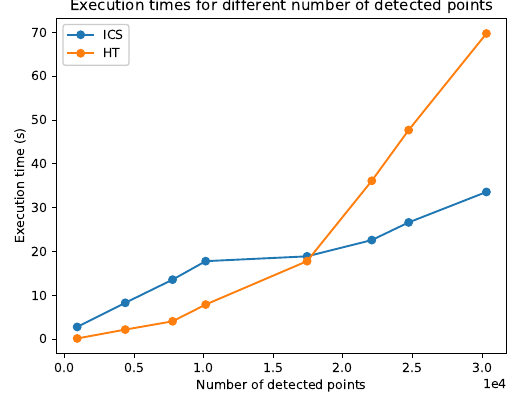
Figure 12. Execution times for different number of detected